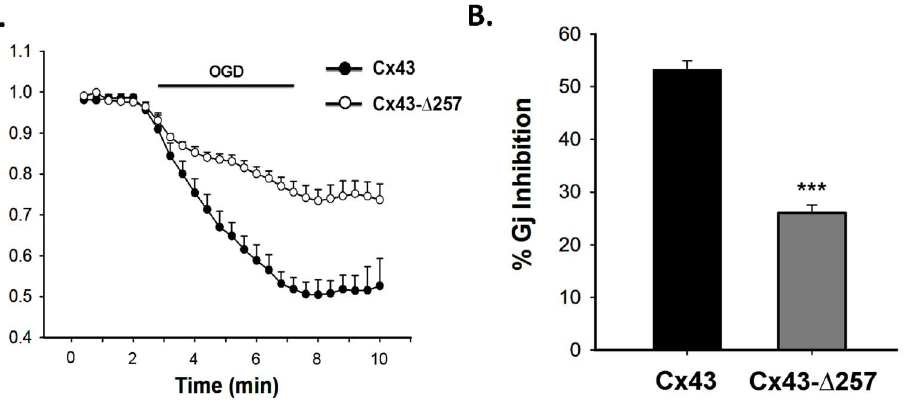
Figure 9. OGD induced uncoupling of CT truncated Cx43 (Cx43- DD 257) . A . G j of CT truncated Cx43 reduced to a lesser extent compared to wild type Cx43, in response to OGD. B . quantitative representation of data generated from 5–7 independent experiments. Values are the mean 6 SEM. ***, p , 0.001.